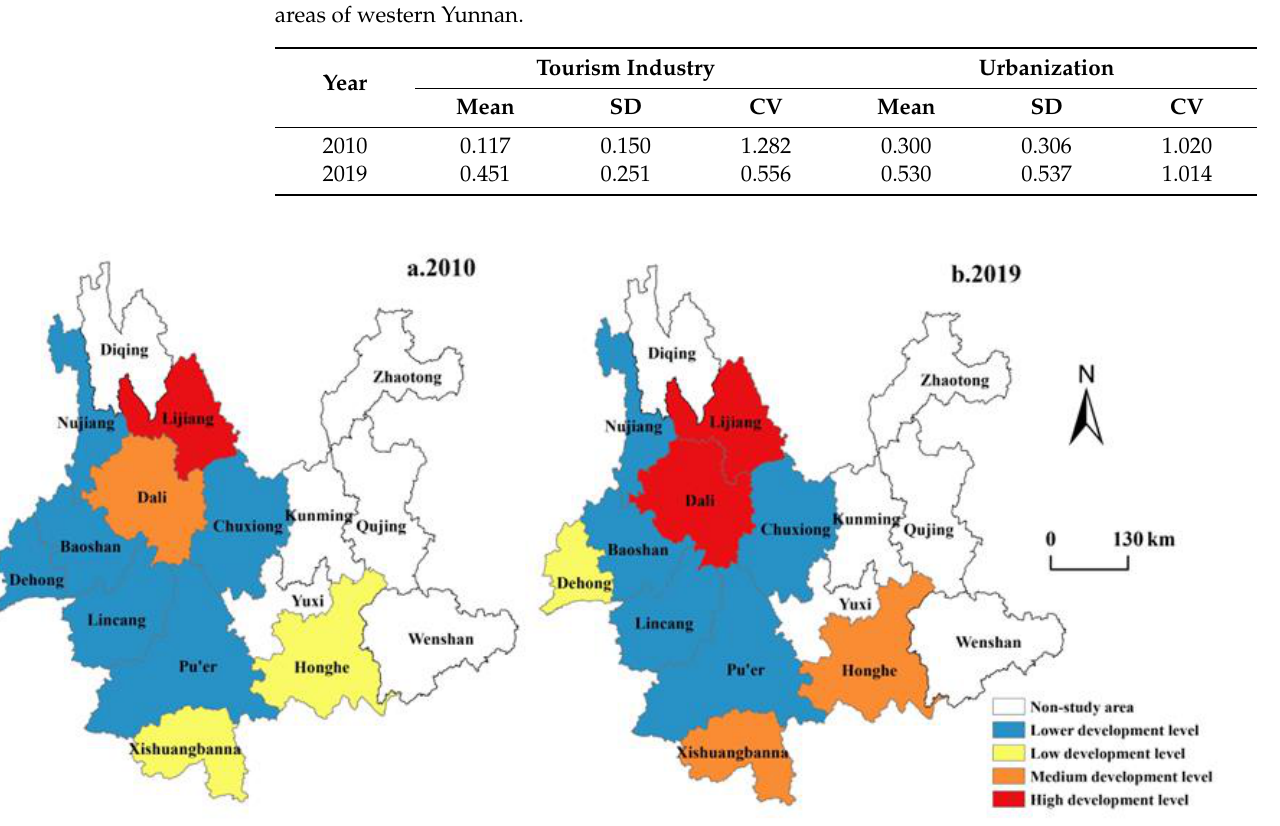
Figure 4. The spatial distribution of urbanization levels in the mountainous border areas of western Yunnan. Table 4. The related statistics of tourism industry and urbanization levels in the mountainous bor- der areas of western Yunnan. Year